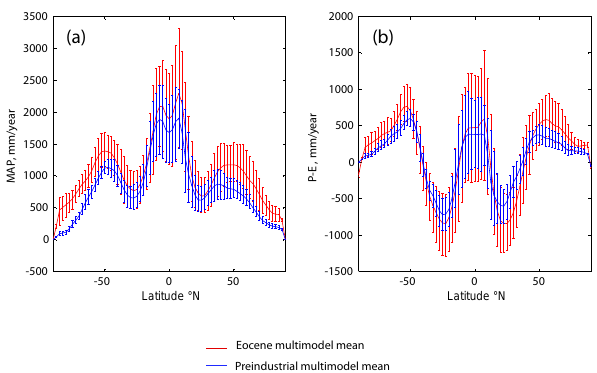
Figure 5. Multimodel mean annual precipitation (a) and mean an- nual precipitation–evaporation ( P − E ) rate (b) for Eocene (red) and preindustrial (blue) boundary conditions. For the Eocene mul- timodel mean, simulations have a global mean precipitation rate of 3.40 ± 0.02mmday − 1 (Table S1); these are HadCM3L (x4), HadCM3L (T) (x4), ECHAM5 (x2), CCSM3 (H) (x4), and a lin- early interpolated distribution between the x4 and x8 CO 2 CCSM3 (W) simulations. Error bars represent the range in values across sim-